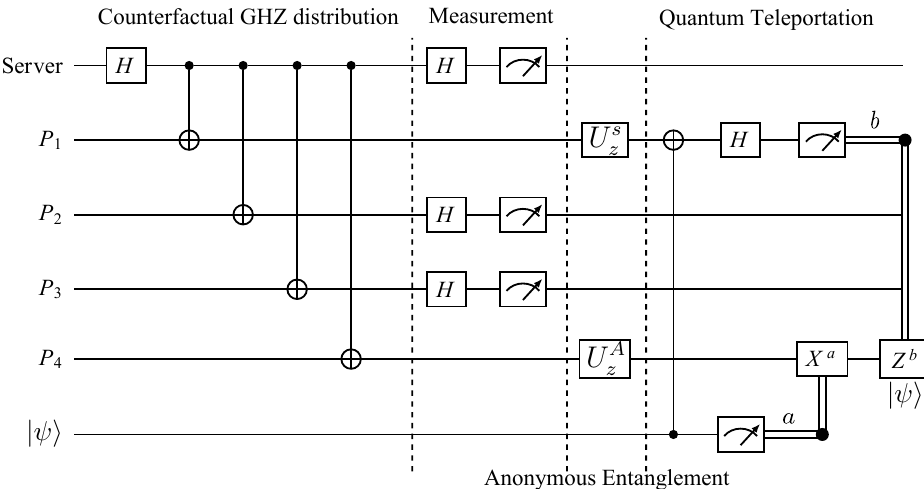
Figure 4. Circuit diagram of counterfactual anonymous quantum teleportation for a network con- sisting of a server and four participants ( P 1 , P 2 , P 3 and P 4 ) . Here, we consider P 1 as the anonymous sender and P 4 as the anonymous receiver. P 1 anonymously wants to send the message preferred receiver P 4 through the counterfactually distributed GHZ state. After the counterfactual GHZ state distribution, all participants except the sender and receiver measure their respective qubits in the basis and announce the results through the classical channel while the sender and the X receiver announce the random classical bit. Then, the sender performs U s z on their qubit, where s denotes the random classical bit created by the server. On the other hand, the receiver performs U A z on their qubit, where A represents the XOR value of the classical announcements of all the other participants except him. Once the anonymous entanglement is established between the sender and the receiver, they perform quantum teleportation in an anonymous manner based on that